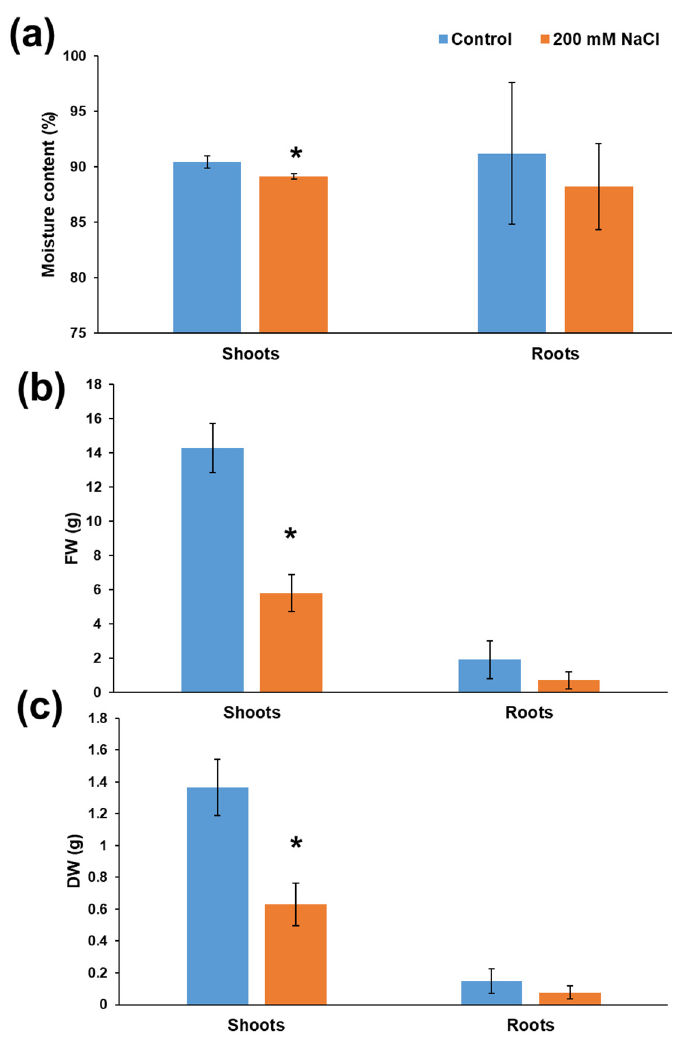
Figure 6. Basic biological parameters in control and salt-exposed Micro-Tom. ( a ) Moisture content (%); ( b ) fresh weight (FW) in g; ( c ) dry weight (DW) in g. Asterisks indicate statistically significant differences at the two-tailed t -test (* p < 0.05).